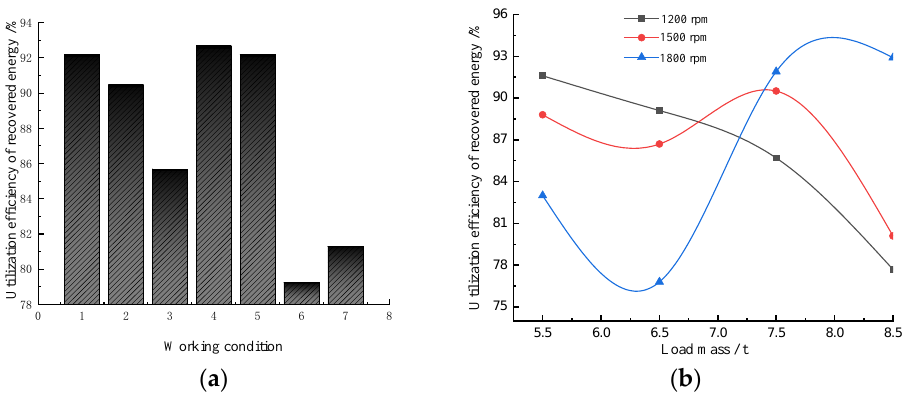
Figure 11. Utilization efficiency of recovered energy with four-quadrant hydraulic pump. ( a ) Com- parative test of 7 working conditions shown in Table 2; ( b ) Utilization efficiency of recovered energy under different load mass.